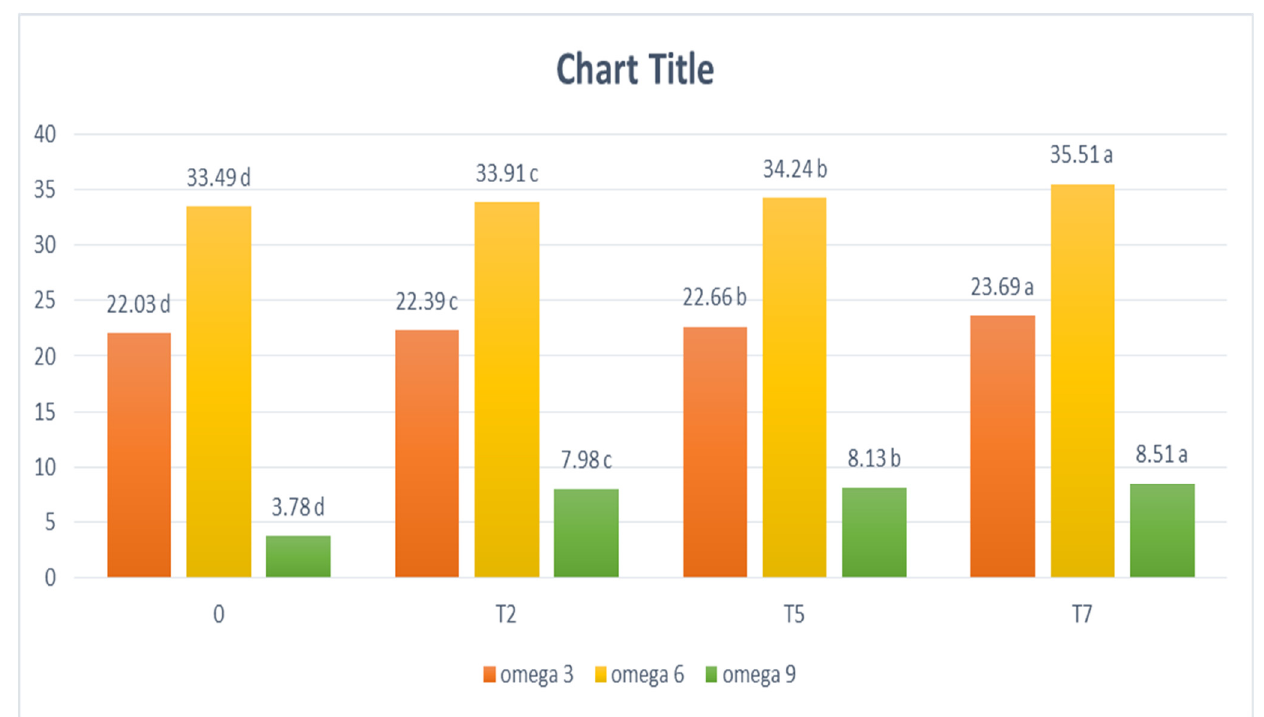
Figure 1. The unsaturated fatty acid content of the cinnamon rolls. Control 0: 100% wheat flour. Treatment 2: 80% resistant starch, 10% lupine flour, 10% flaxseed flour. Treatment 5: 65% resistant starch, 25% lupine flour, 10% flaxseed flour. Treatment 7: 55% resistant starch, 35% lupine flour, in addition to 10% flaxseed flour for all. Mean values with the same letters were not significantly different ( p ≤ 0.05). Mean values with different letters were significantly different ( p ≤ 0.05).